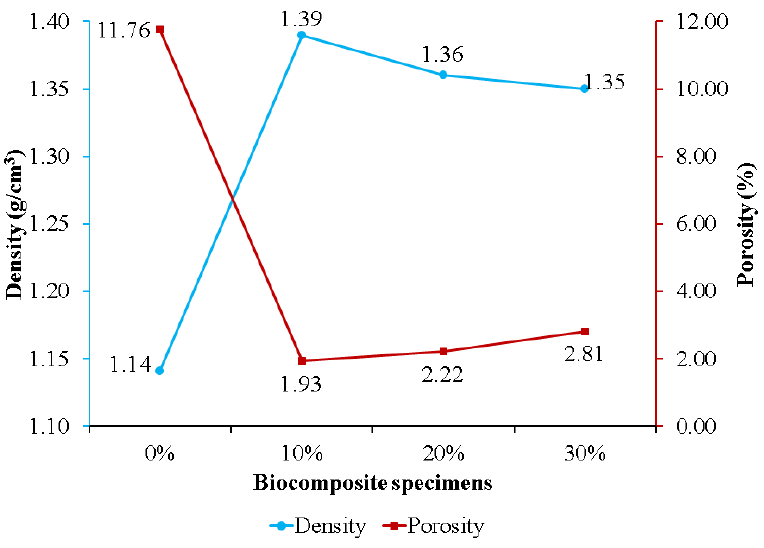
Figure 5. The density and porosity of PLA/PCL/nHA